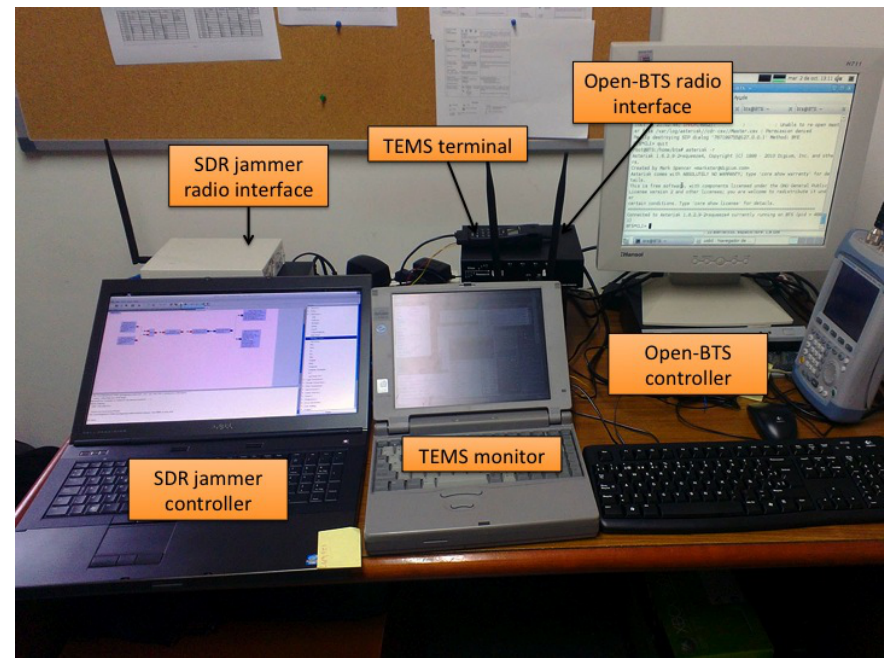
Figure 9. Experimental cognitive BTS